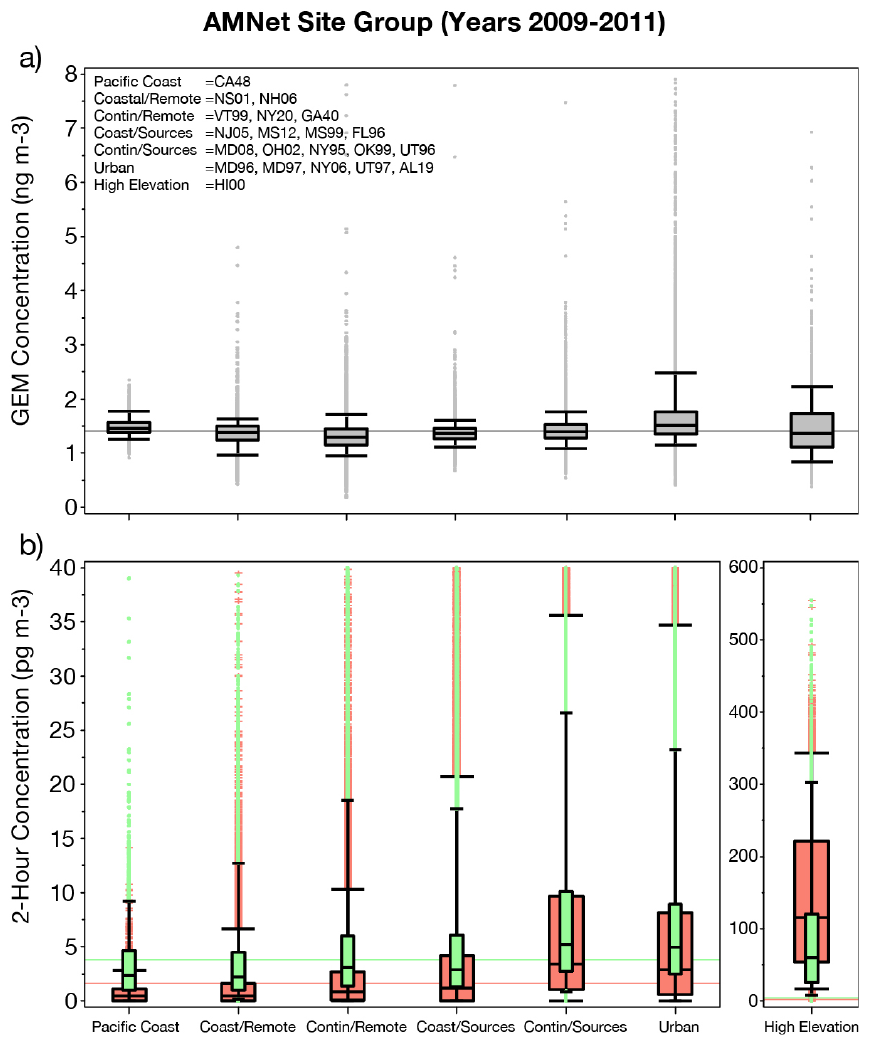
Fig. 3. Box-and-whisker plots of gaseous elemental mercury (GEM, ngm − 3 , a ), and for gaseous oxidized and particulate-bound mercury (GOM in red, PBM 2 . 5 in green, pgm − 3 , b ) observations for site groupings for years 2009 to 2011. Each box includes the median (midline), 25th and 75th percentiles (box edges), 5th and 95th percentiles (whiskers), and individual values outside these limits (dots/pluses). Values above 8.0ng m − 3 and 40pgm − 3 , respectively, are not shown. The respective medians of all observations are shown for reference (silver, red and green lines, without HI00 for GOM and PBM 2 . 5 )